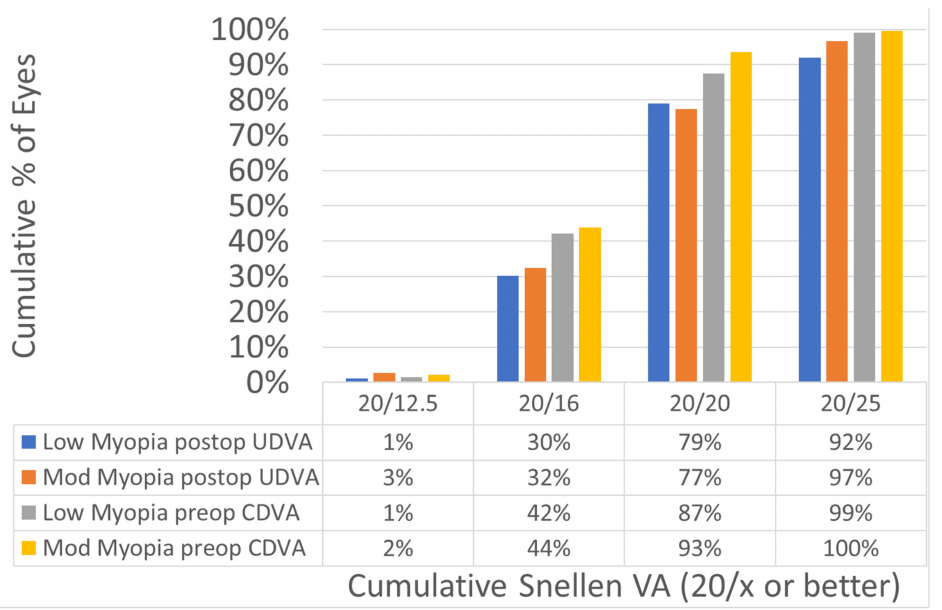
Figure 1. Efficacy comparing the preoperatively corrected distance visual acuity (CDVA) with the postoperatively uncorrected distance visual acuity (UDVA). The efficacy of the treatments was not different between the two myopic groups: 30% of the eyes in the low myopia and 32% of the eyes in the moderate myopia achieved UDVA of 20/16 or better postoperatively.